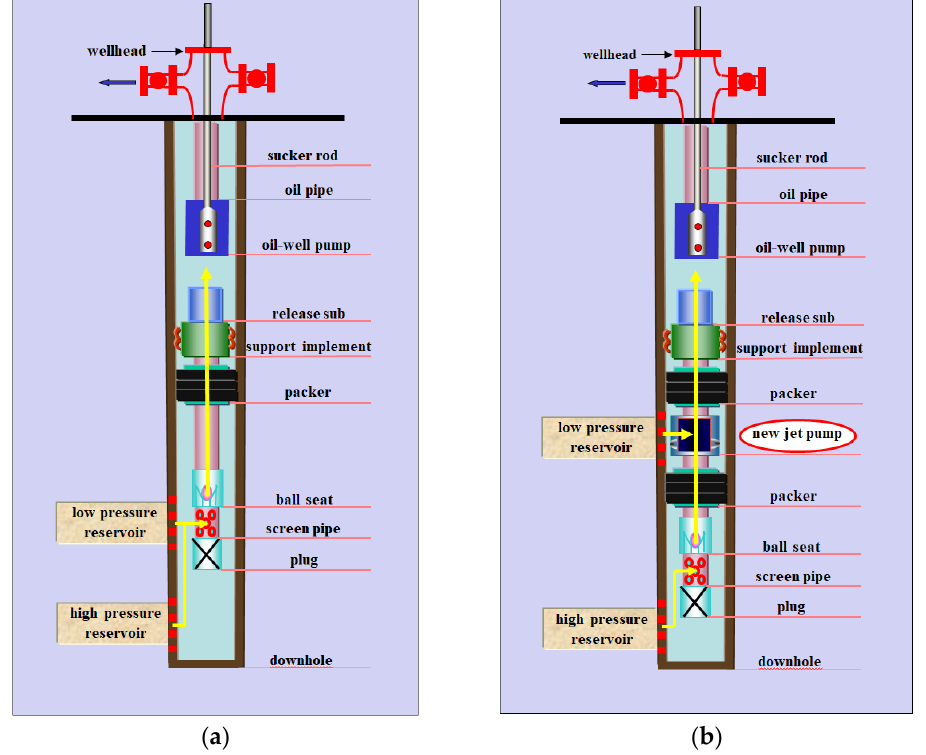
Figure 1. Comparison between a conventional co-production string and a co-production string with a deep-well jet pump. ( a ) Schematic diagram of a conventional co-production string. ( b ) Schematic diagram of a co-production string with a new jet pump.